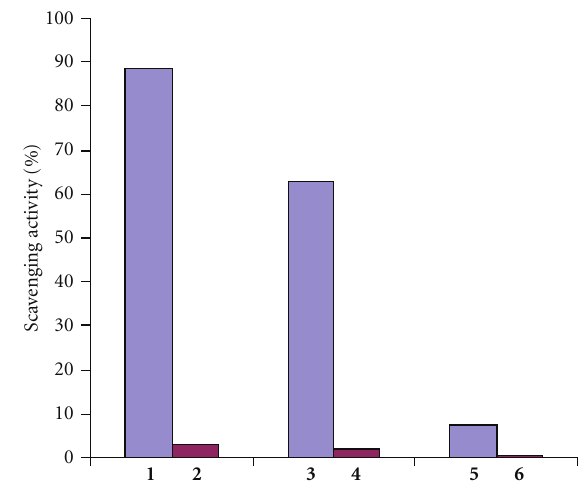
Figure 2: Scavenging activity for compounds 1 – 6 in DPPH test (MeOH, 20 ◦ C, 100 μ